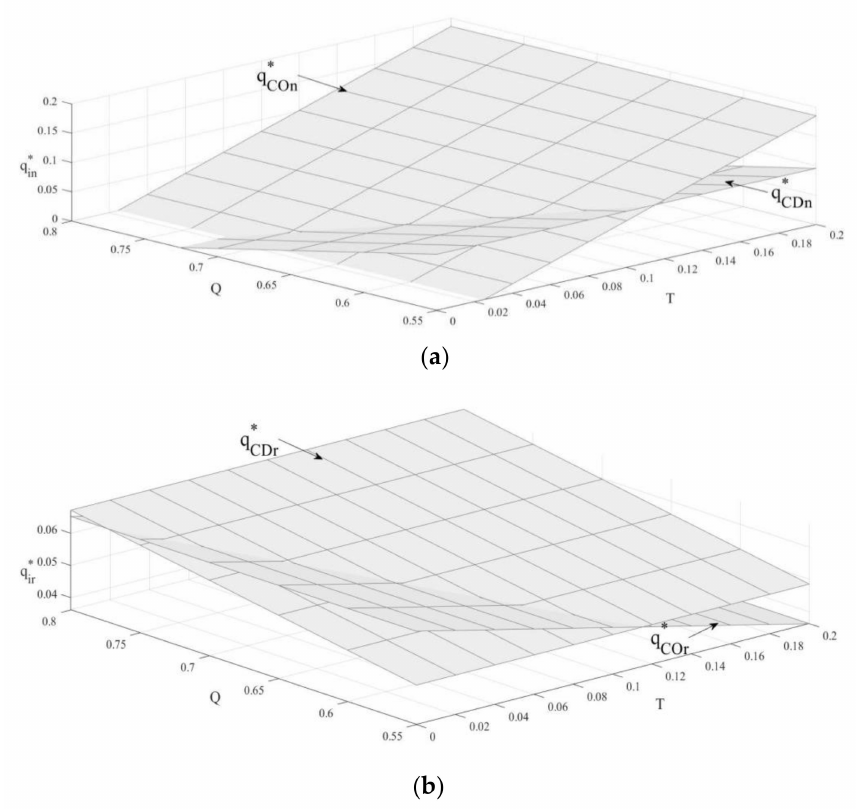
Figure 2. The influence of carbon emission constraint and carbon trade on sales volume. ( a ) The influence on new products. ( b ) The influence on remanufactured